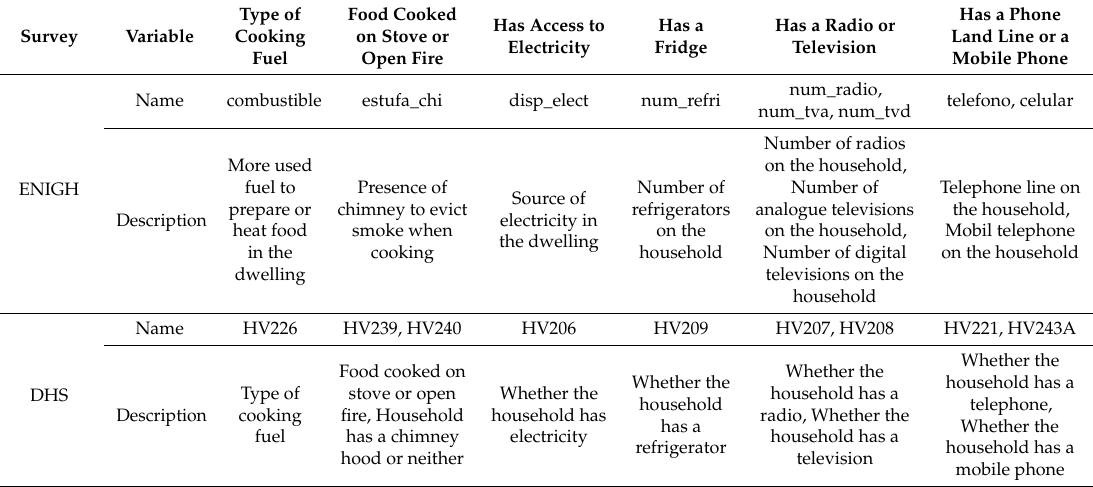
Table 2. Variable equivalence for the databases used in the